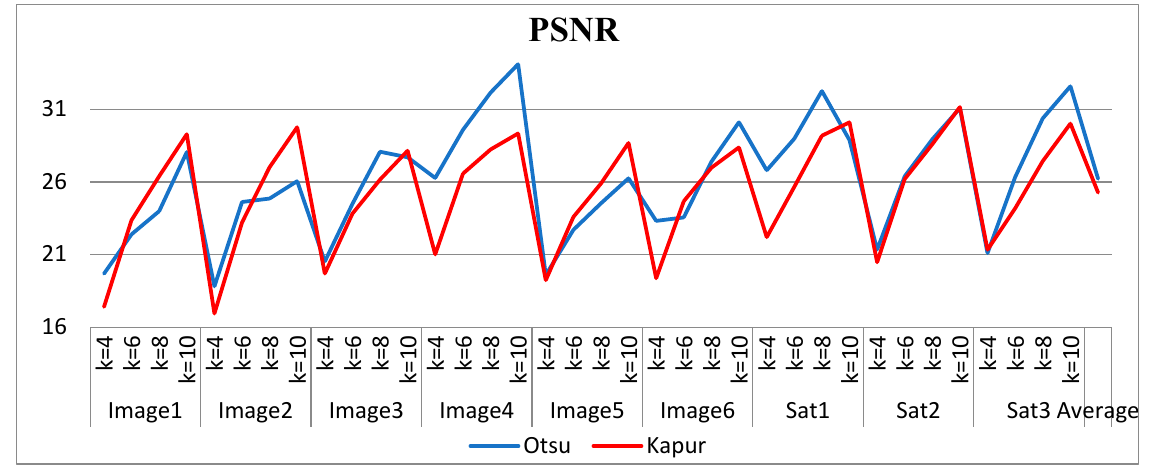
Figure 8. Comparison of PSNR for the proposed method using Otsu’s and Kapur’s methods.